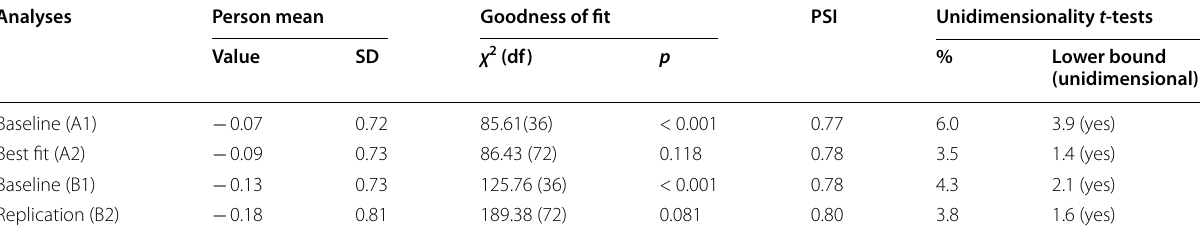
400) and replication with =